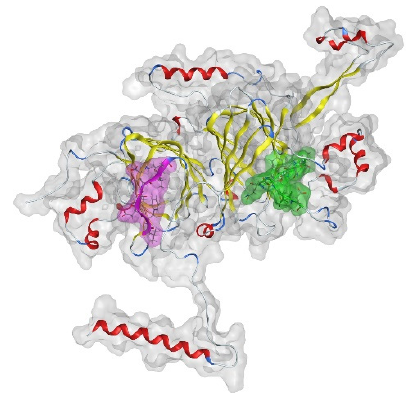
Figure 7. Visualization of the position of selected modified peptides K.FFLAGNPQQQGGGK.E ( α - chain; green-colored segment) and K.VFDDEVK.Q ( β -chain, pink-colored segment) in the monomer of coffee 11S storage protein.